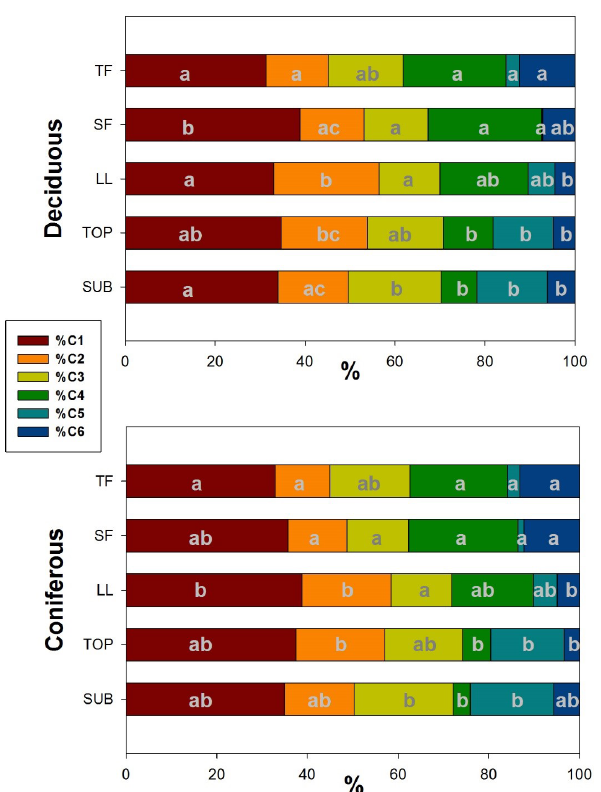
Figure 7. Mean distribution of PARAFAC components in samples from different ecosystem fluxes of deciduous (age class and un- managed) and coniferous forests. Letters (reading vertically) indi- cate differences between samples from different ecosystem fluxes regarding PARAFAC components within each management cate- gory (Nemenyi–Damico–Wolfe–Dunn tests). TF: throughfall; SF: stemflow; LL: litter leachate; TOP: topsoil solution; SUB: subsoil solution.